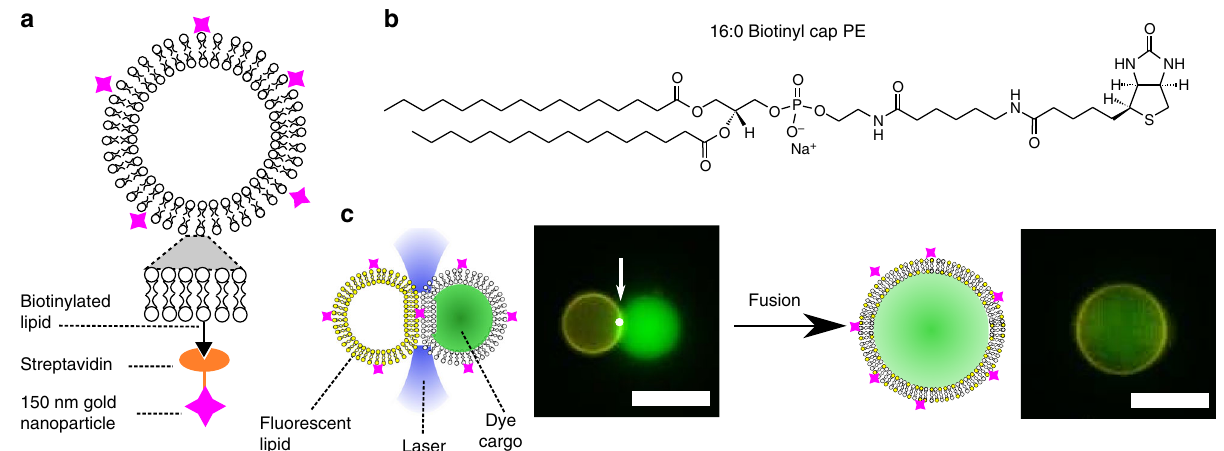
Fig. 7 AuNP-mediated vesicle fusion. a Schematic of the AuNP-labelled vesicle. b Chemical structure of the biotinylated lipid. c Schematic and fl uorescence microscopy image of VIM fusion. A Rh-PE-labelled vesicle (yellow channel) is fused with a calcein-containing vesicle (green channel) with the application of a laser (white dot) at the VIM (white arrow) to yield a vesicle carrying both fl uorescent lipid and fl uorescent cargo. Scale bar = 5 µ m for all images